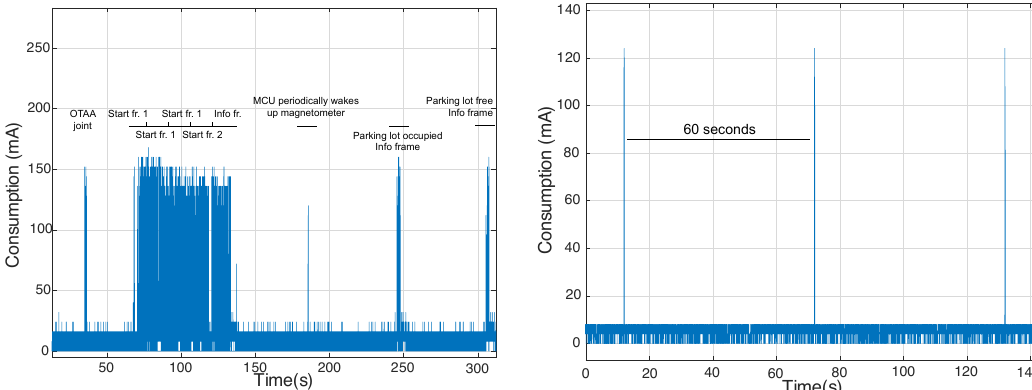
Figure 3. ( left ) Libelium Smart Parking sensor consumption during the initial OTAA connection to the gateway. ( right ) Libelium Smart Parking sensor consumption between two microcontroller wakeup periods.